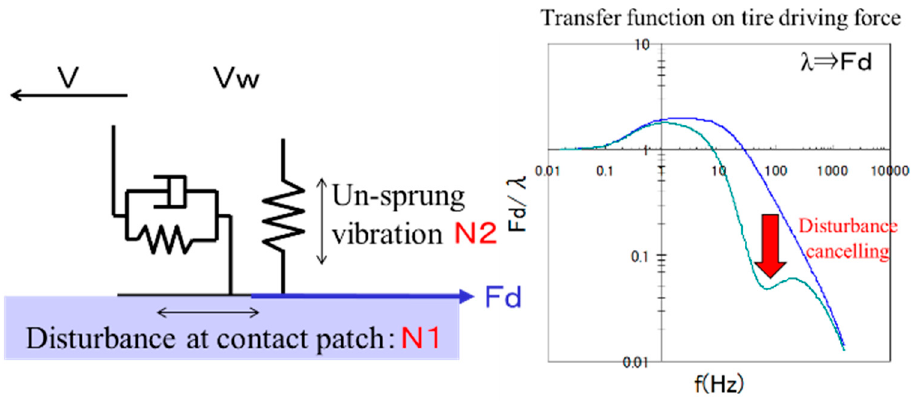
Figure 2. Design of tire disturbance controller for mechanical tire noise cancellation.